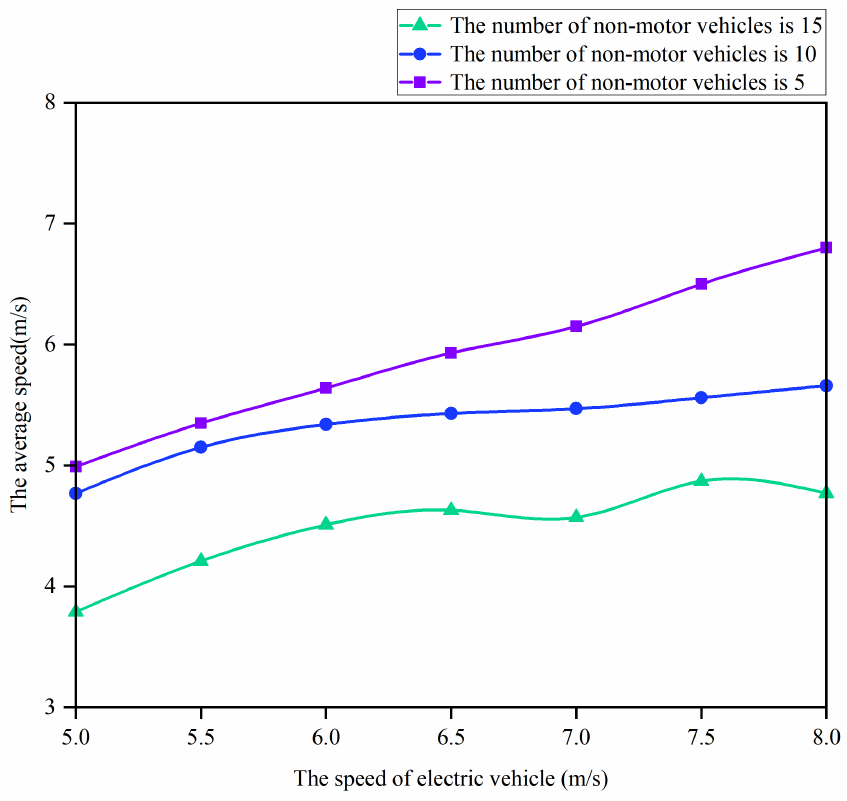
Figure 13. The influence of the average speed of electric vehicles on the overall traffic speed of the